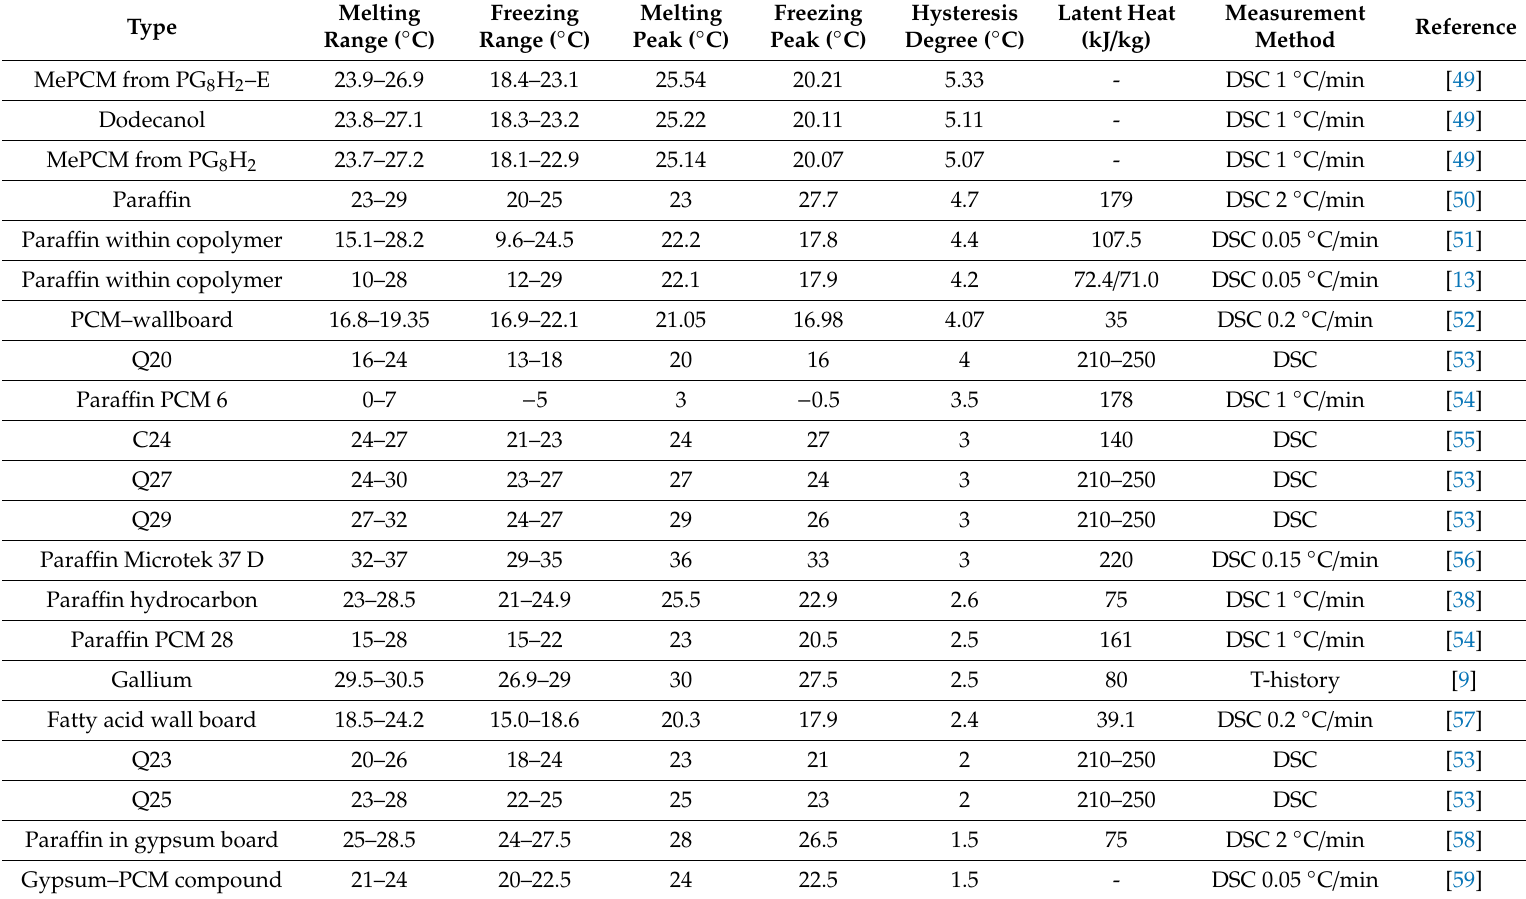
Table A1. The thermal properties of PCM found in the literature for building applications (the hysteresis degree is calculated as the di ff erence between melting peak and freezing